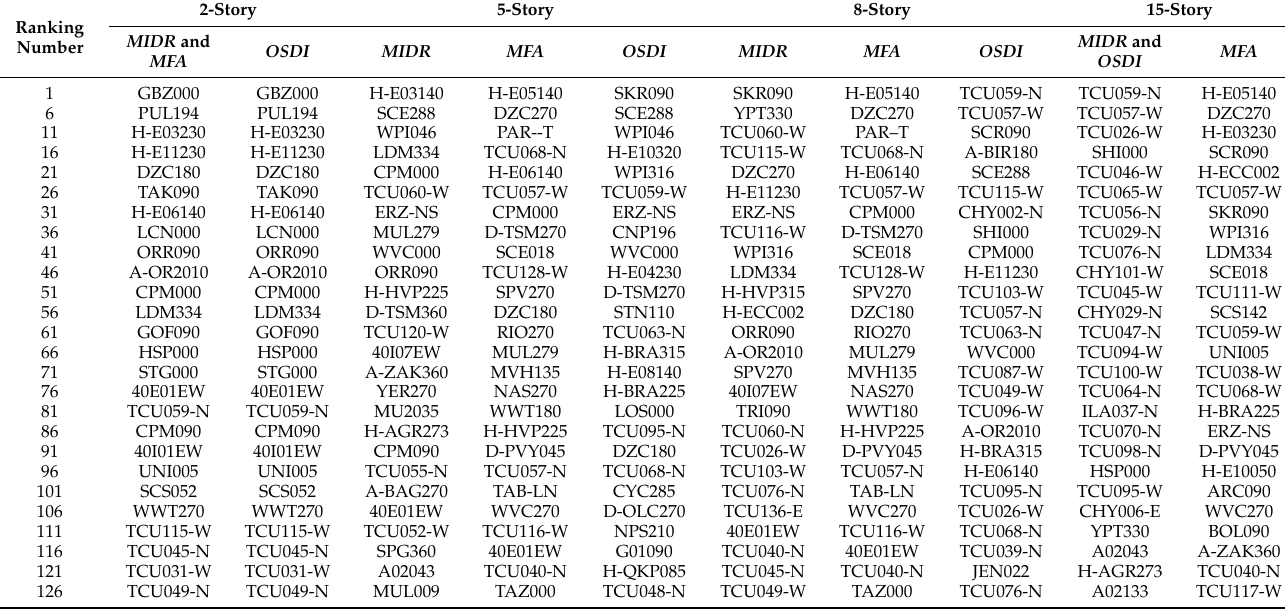
Table A1. Damage potential ranking of pulse-like ground